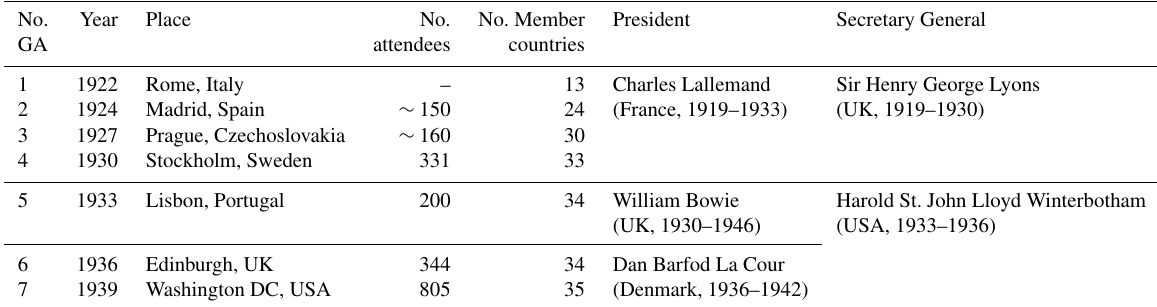
Table 1. IUGG General Assemblies from 1922 to 1939, and IUGG Presidents and Secretaries General.